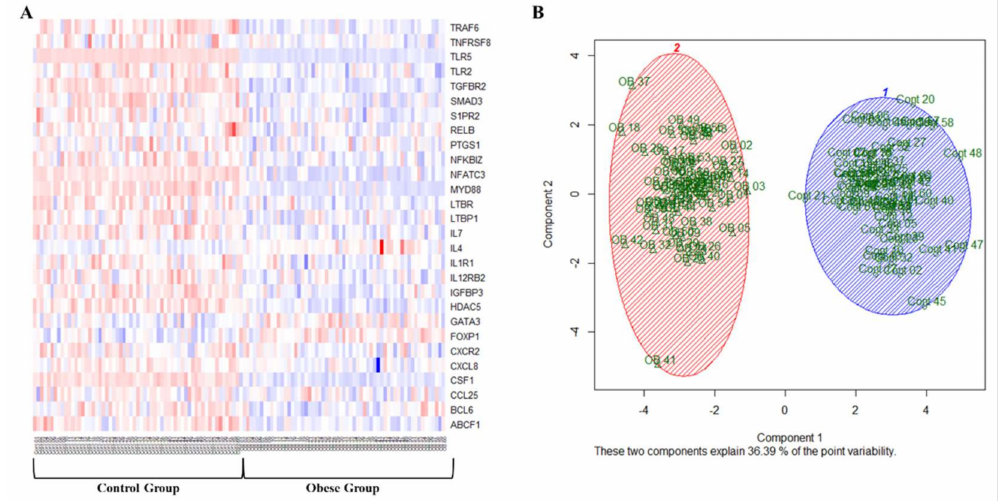
Figure 3. Differentially methylated adipokines in VAT biopsies. ( A ) A representative heatmap of the promoter methylation % of 24 differentially methylated adipokines in VAT samples obtained from obese and non-obese subjects ( n = 60, each). The heatmap uses a color key that ranges from red (high) to blue (low) based on methylation level. ( B ) A scatterplot of the first two principal components demonstrates a general separation of the obese and non-obese